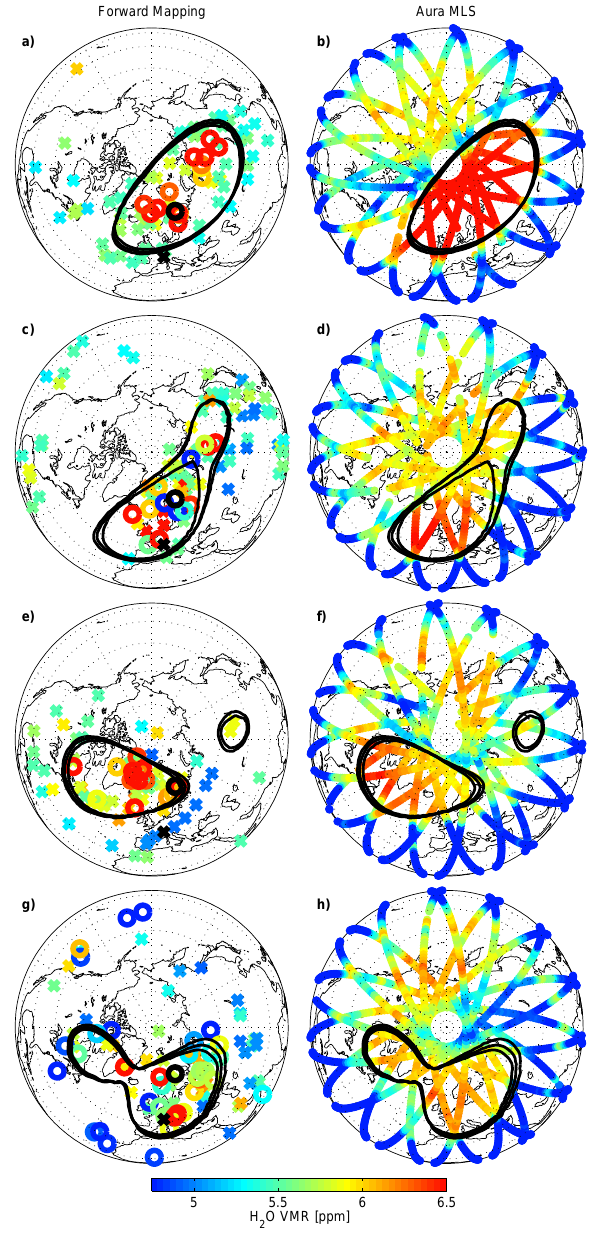
Fig. 8. Same as Fig. 7, but for a pressure layer between 14 and